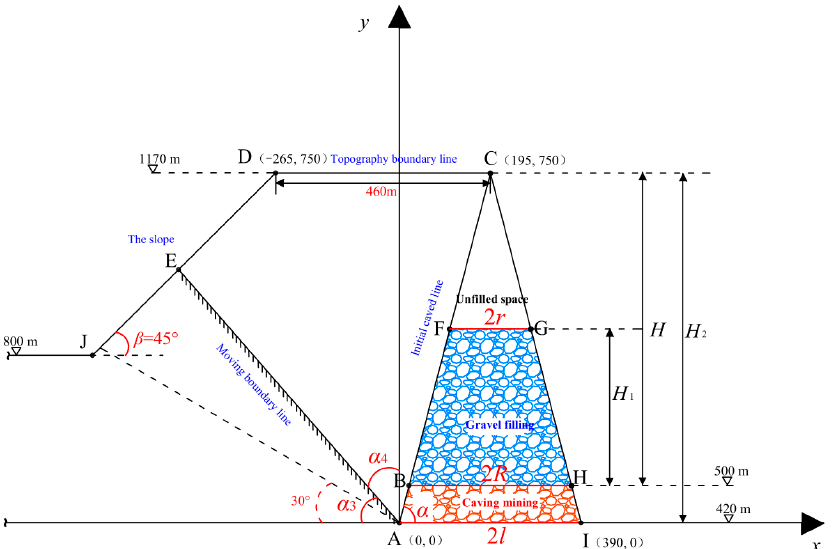
rectangular coordinate system, and takes the boundary point A of the 420 subsection as ( H 2 = 750 m). Thus, the initial caving angle ( α ) is 75 ◦ .